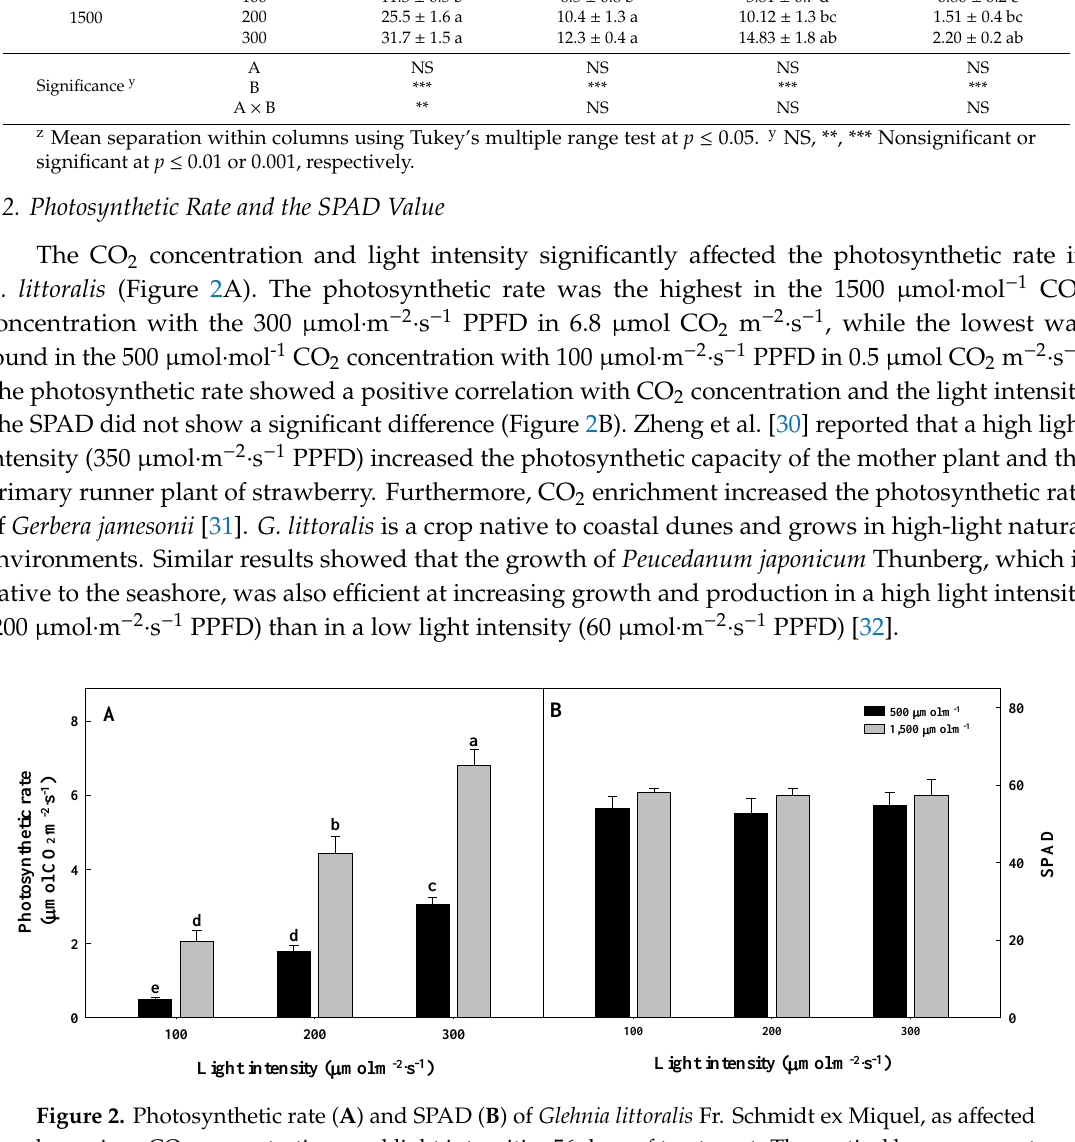
Table 2. The different root growth characteristics of Glehnia littoralis Fr. Schmidt ex Miquel, as affected by various CO 2 concentrations and light intensities after 56 days of treatment ( n = 3). CO 2 Concentration ( µ mol · mol − 1 ) (A)